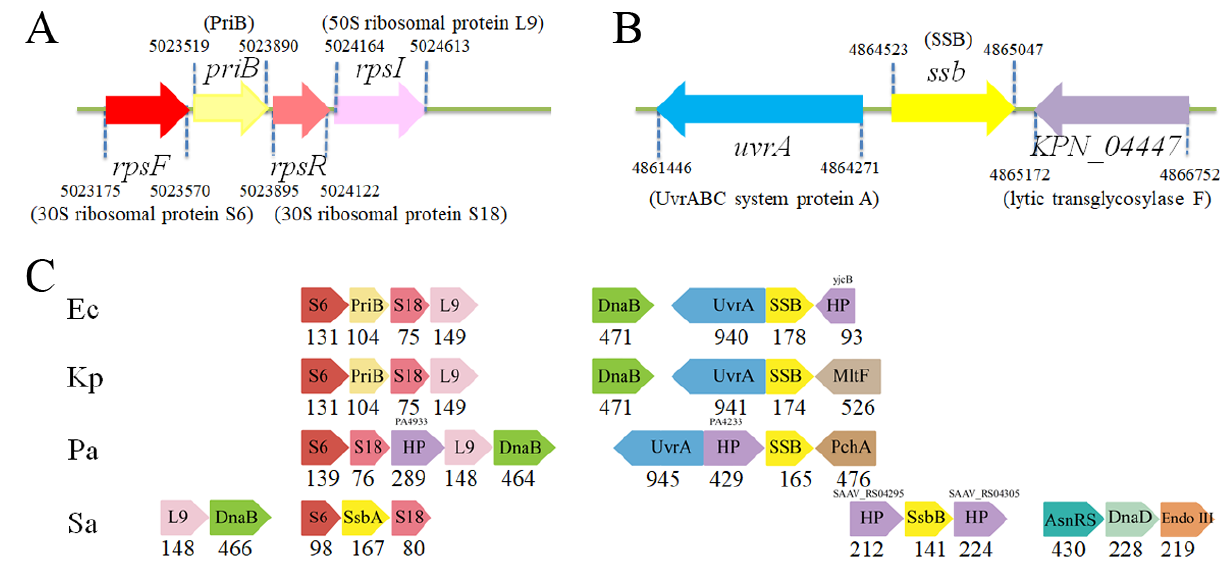
Figure 10. Gene map of K. pneumonia chromosomal region with priB and ssb . ( A ) The gene coding for KpPriB maps from the 5023519 to 5023890 nt of the K. pneumonia genome. This priB gene is flanked by the rpsF and rpsR genes, coding for the ribosomal proteins S6 and S18, respectively. ( B ) The gene coding for KpSSB maps from the 4864523 to 4865047 nt of the K. pneumonia genome. This ssb gene is located adjacent to the uvrA and KPN_04447 genes, coding for the excinuclease ABC subunit UvrA and lytic transglycosylase F (also identified as the periplasmic binding protein MltF), respectively. ( C ) Gene arrangements around the priB and ssb genes in different bacterial genomes. The priB gene organization in K. pneumonia , as well as in the Gram-negative bacterium E. coli (but not P. aeruginosa ), resembles ssb ( ssbA ; the main ssb ) gene organization in the Gram-positive bacteria S. aureus and B. subtilis . Gene maps of the DnaB helicase, DnaD loader, and SsbB (the second ssb ) are also shown. The number is the gene product length (aa). HP, hypothetical protein; L9, the 50S ribosomal protein L9; PchA, isochorismate synthase; AsnRS, asparaginyl-tRNA